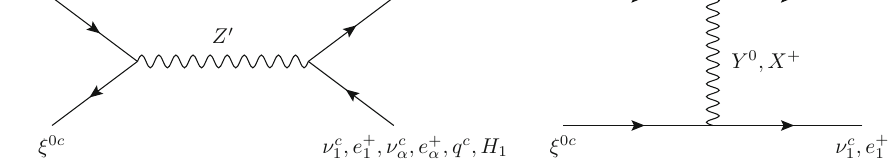
Fig. 6 The masses of the new scalar fields and the odd gauge bosons as functions of w according to the several relations between w and (cid:11) , where the dark field lines are put as red and the DM unstable regime is input as light red background, which is bounded by X , Y line Fig. 7 Dominant